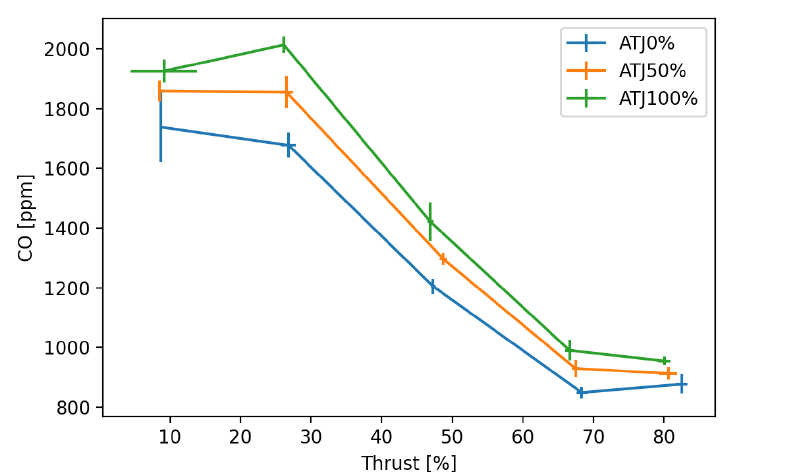
Figure 13. GTM-140/ATJ: CO